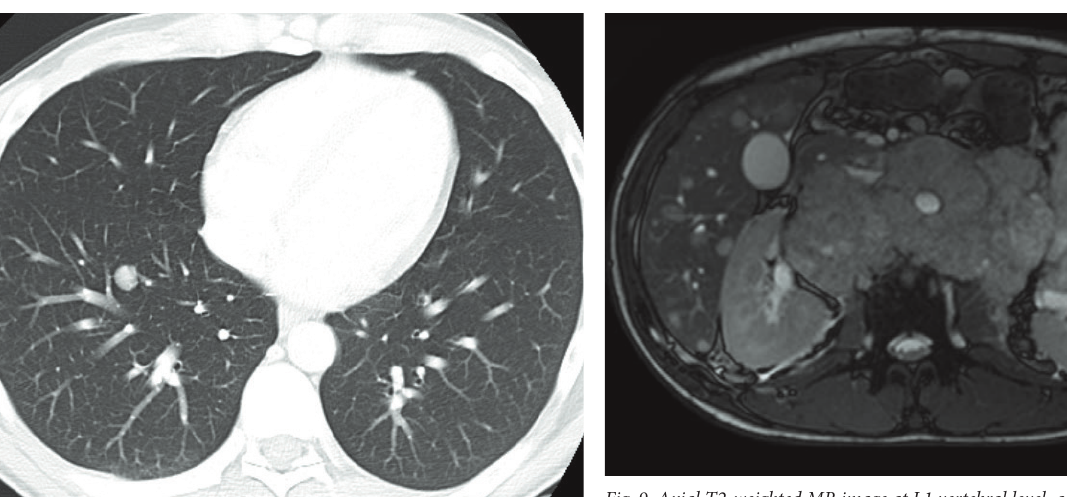
Fig. 9. Axial T2-weighted MR image at L1 vertebral level, adjacent to the renal hilar and segment 6 of the liver.